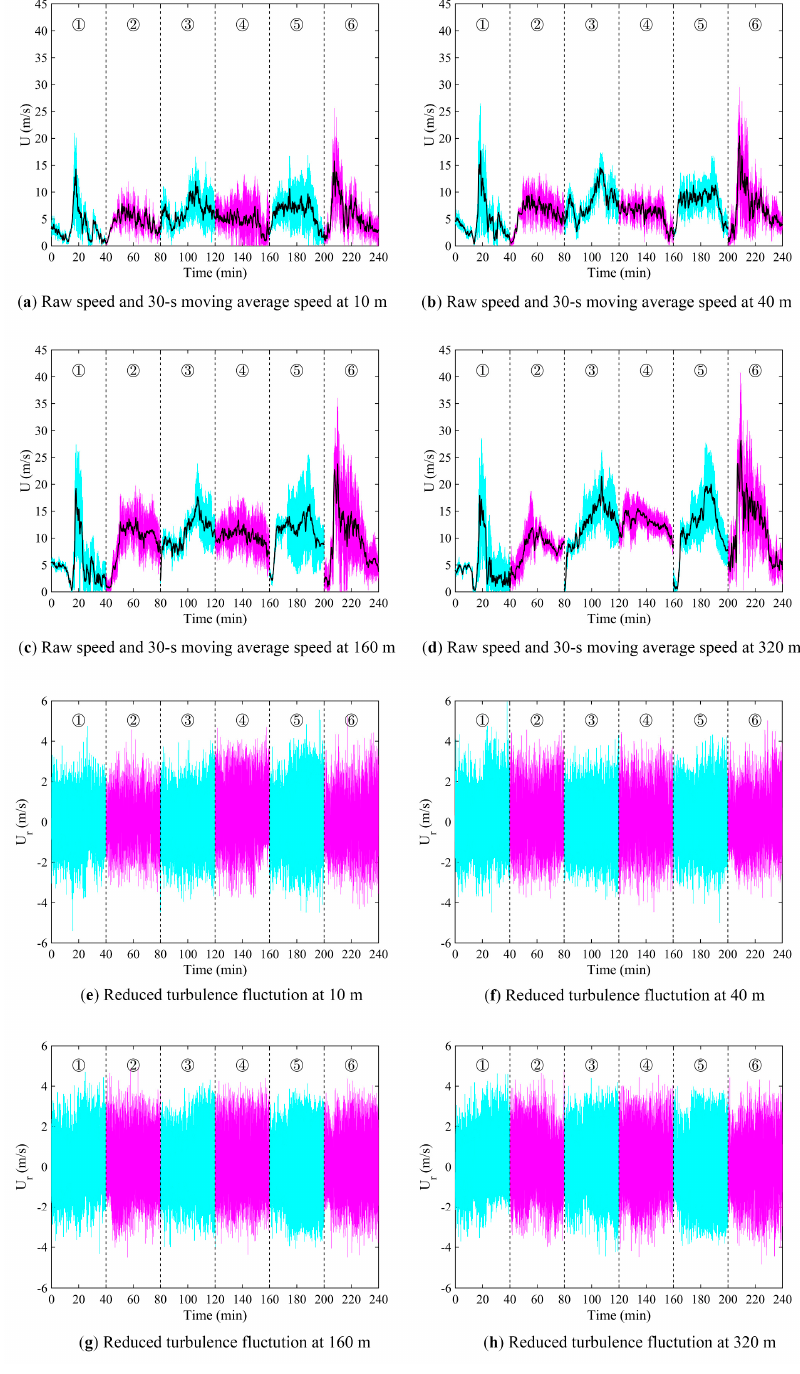
Figure 8. Time histories of ( a – d ) measured and slowly varying mean wind speed, and ( e – h ) reduced turbulence fluctuation, at height levels of 10, 40, 160 and 320 m during 6 events.